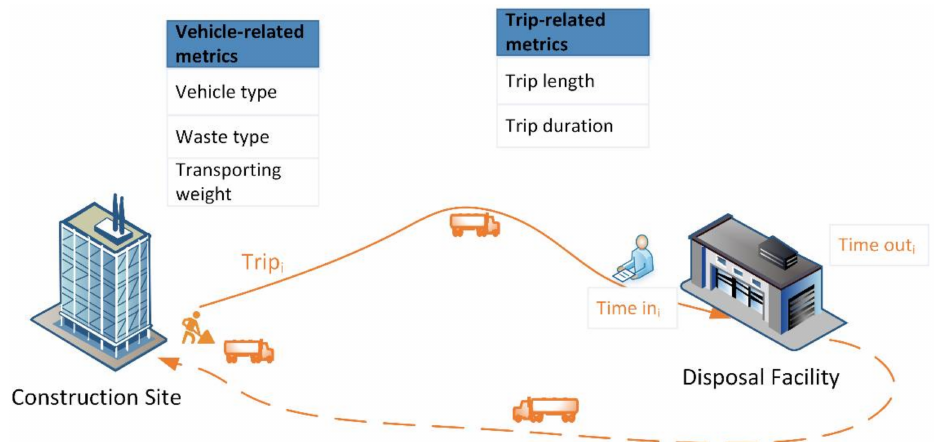
Figure 1. Freight performance metrics for construction waste hauling